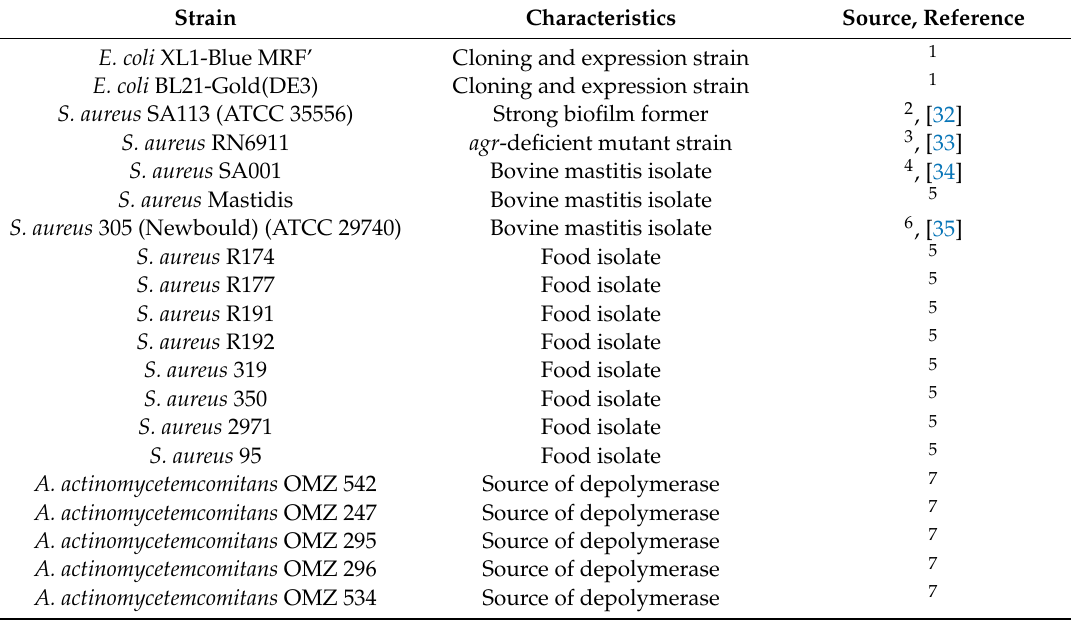
Table 1. Bacterial strains used in this work. Strain